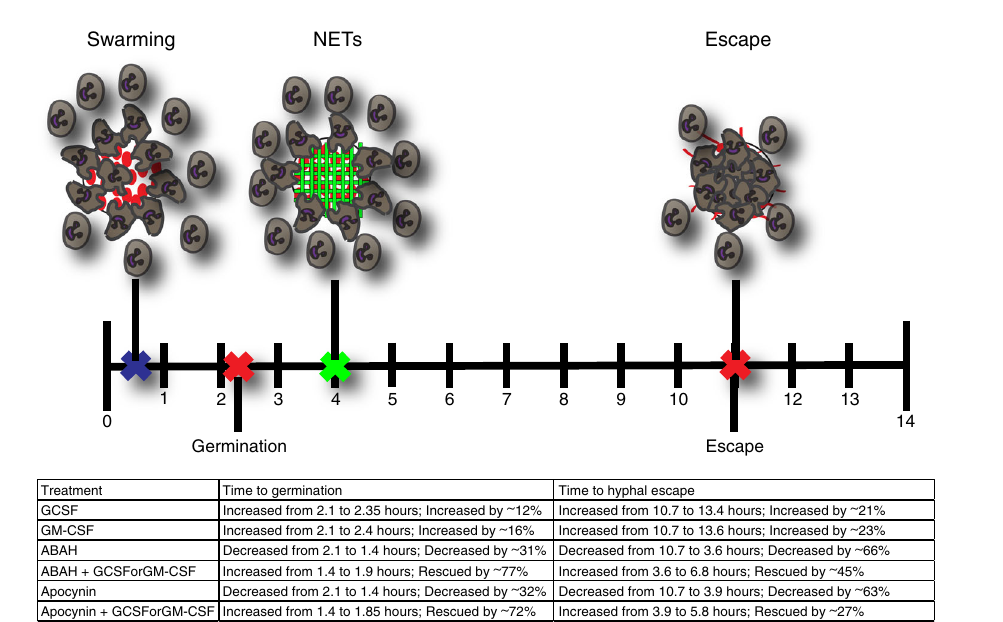
Fig. 8 Summary of neutrophil swarming inhibition and enhancement. A timeline of the four major events in a 14-hour neutrophil swarming assay against C. albicans : neutrophil swarming, fungal germination, neutrophil NETs release, and hyphal escape. The average time of these events during swarming with healthy neutrophils is indicated with small “ Xs ” and cartoon depictions. The table summarizes the changes which occur to these events during treatment with different inhibitors (Apocynin and ABAH) and enhancers (GM-CSF and GCSF). Changes under the effect of inhibitors could be partially restored by the enhancers.